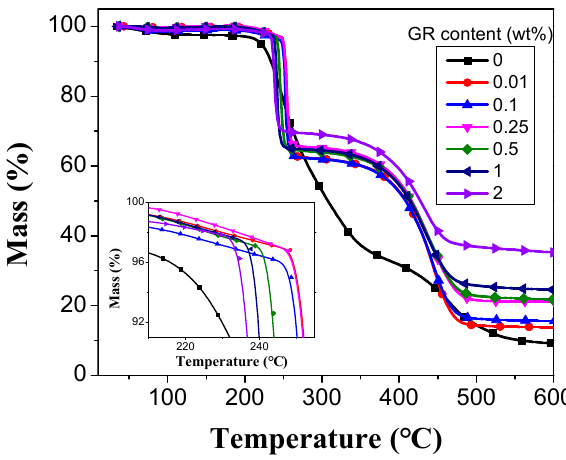
Figure 5. Thermogravimetric (TG) curves of PVA/GR nanofiber films as related to the content of graphene. Table 2. TG results of PVA/graphene (GR) nanofiber films.